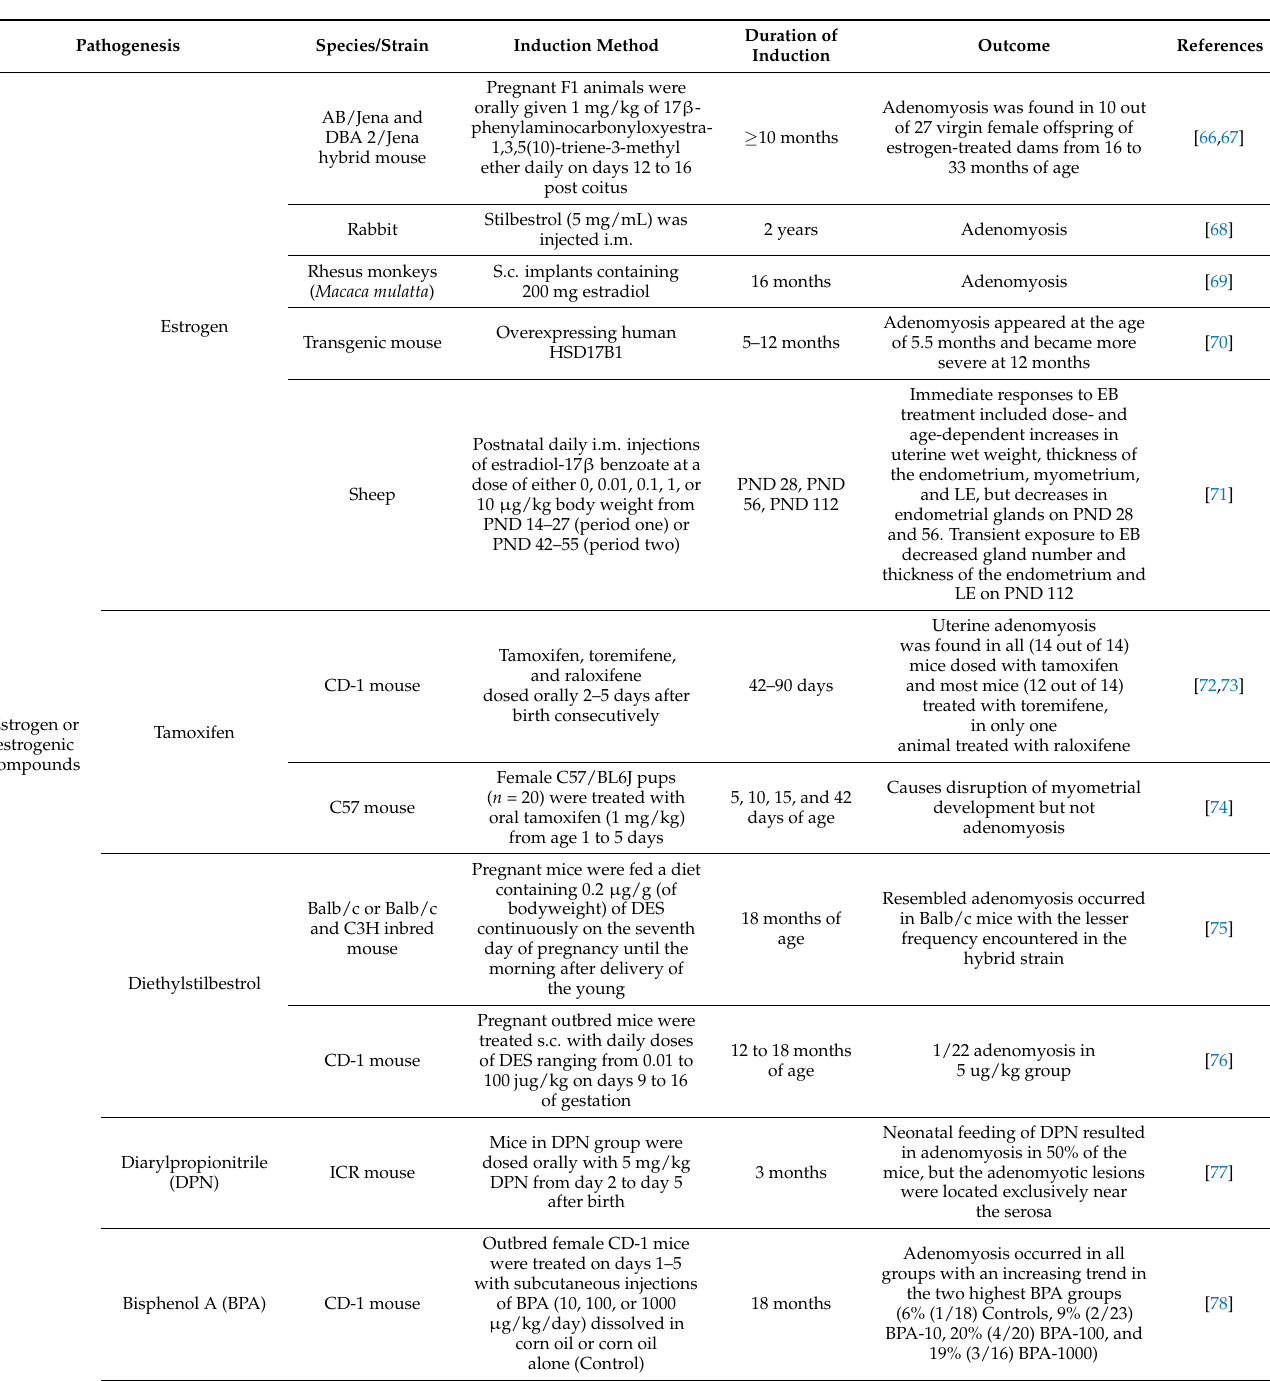
Table 1. Summary of animal adenomyosis models by species, strain, induction method, duration of induction, and